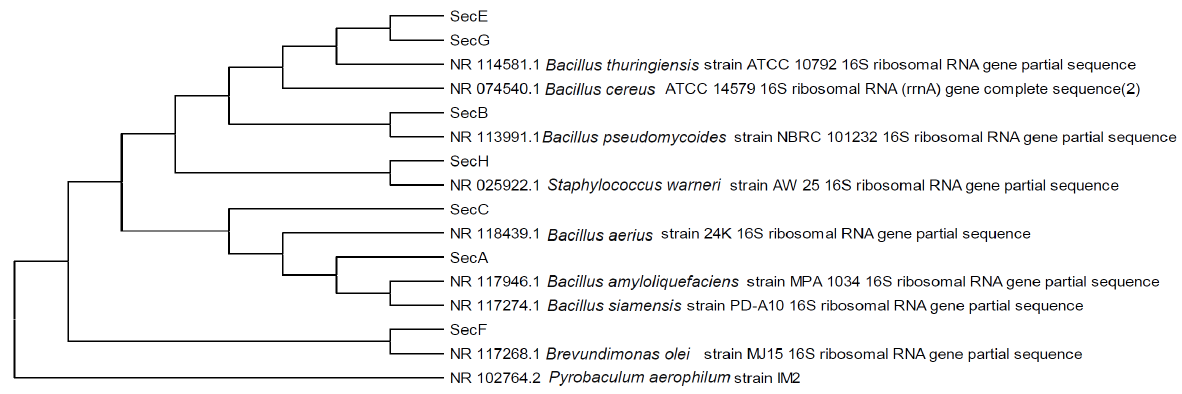
Figure 3. Phylogenetic analysis based on 16S rRNA gene sequences, from soil isolates with reference sequences. The tree was produced by Neighbor-Joining method with 1000 repetitions Tamura 3 model parameters (Tamura 1992) considering Gamma distribution with 5 category rates, using Mega 6.0 software (Kumar et al. 2016).